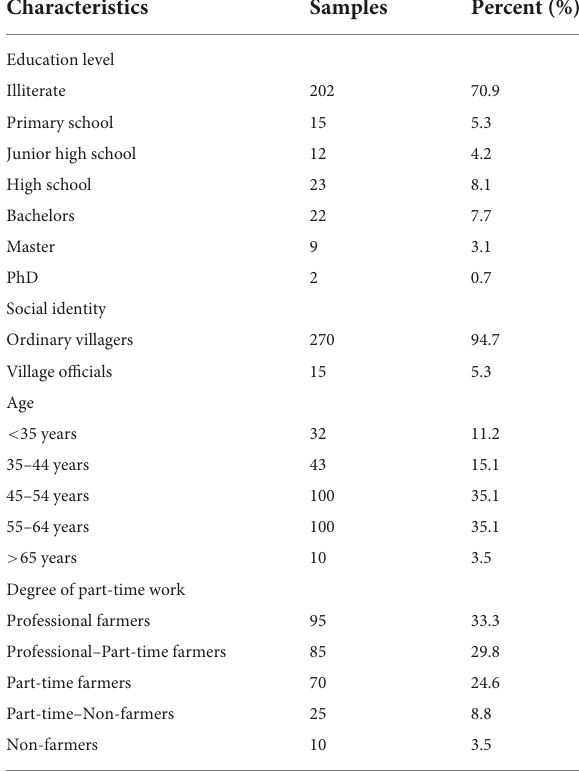
TABLE 1 Scale development and questionnaire